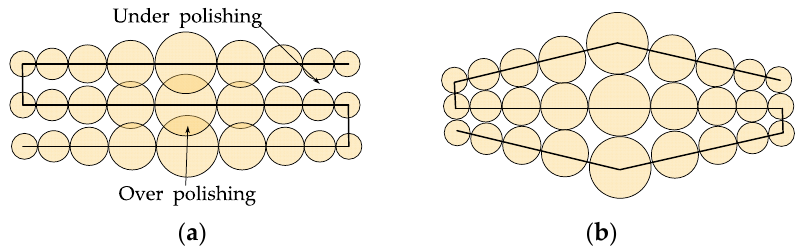
Figure 19. The schematic diagram of the polishing path: ( a ) Physically and ( b ) geometrically uniform coverage. Reproduced with permission from [150].